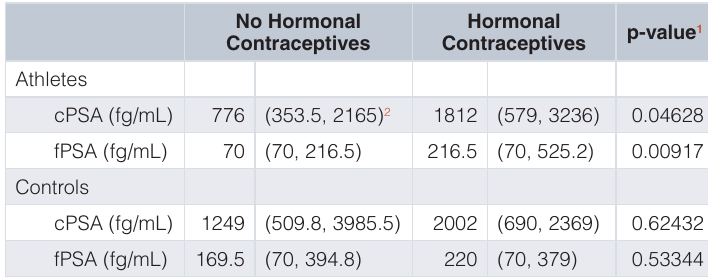
Table 3. Comparison of cPSA and fPSA levels between women who take hormonal contraceptives and those who do not, for athletes and controls. Numbers represent medians (25th, 75th percentiles).